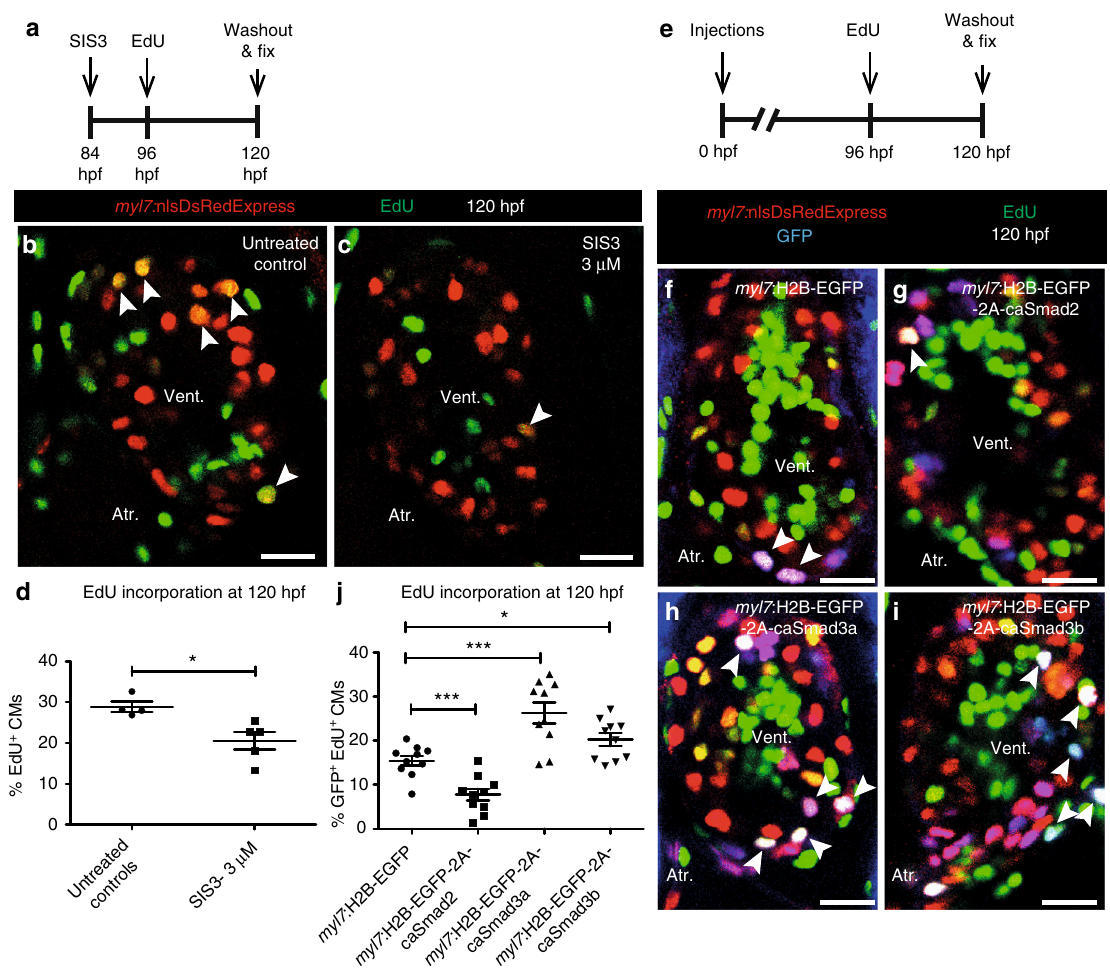
Fig. 6 CM proliferation is inversely regulated by Smad2 and Smad3. a Experimental setup of SIS3 treatment, followed by EdU treatment and fi xation. b , c Tg (myl7:nlsDsRedExpress) hearts of untreated control and 3 µ M SIS3-treated larvae at 120 hpf; α -DsRed (red), EdU (green). White arrowheads point to proliferating CMs (EdU + /DsRed + ). d Quanti fi cation of CM proliferation in untreated control ( n = 4) and 3 µ M SIS3-treated ( n = 5) ventricles at 120 hpf. e Experimental setup of injections, followed by EdU treatment and fi xation. f – i Tg(myl7:nlsDsRedExpress) hearts of myl7:H2B-EGFP , myl7:H2B-EGFP-2A- caSmad2 , myl7:H2B-EGFP-2A-caSmad3a and myl7:H2B-EGFP-2A-caSmad3b injected larvae at 120 hpf; α -DsRed (red), α -GFP (blue), EdU (green). White arrowheads point to proliferating CMs (EdU + /DsRed + /GFP + ). j Quanti fi cation of CM proliferation in myl7:H2B-EGFP ( n = 10), caSmad2 ( n = 10), caSmad3a ( n = 10), and caSmad3b ( n = 10) injected ventricles at 120 hpf. All cell counts were performed on non-overlapping confocal planes (thickness, 1 µ m) (data are mean ± s.e.m., * P ≤ 0.05 and *** P ≤ 0.001 — Student ’ s t test, two-tailed). Scale bars, 20 µ m. vent., ventricle; atr.,